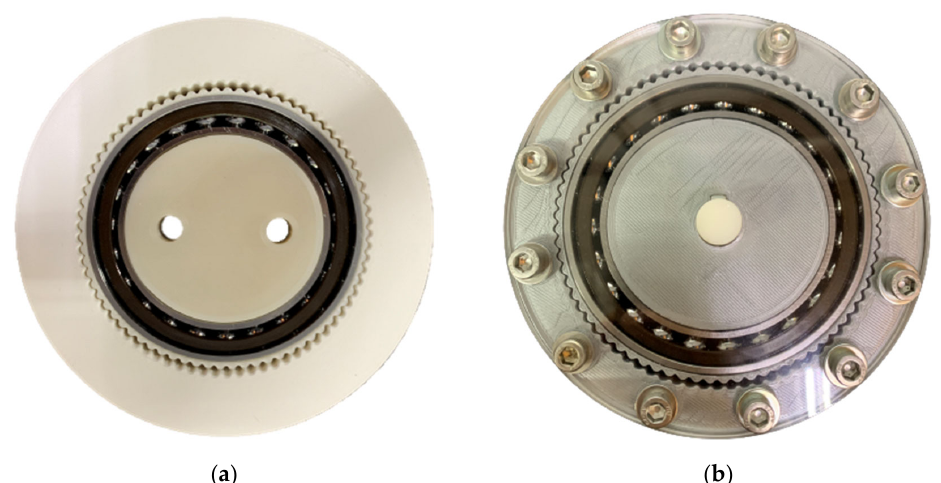
Figure 10. Mock ‐ up model to check ( a ) the gear engagement ( b ) the operation.